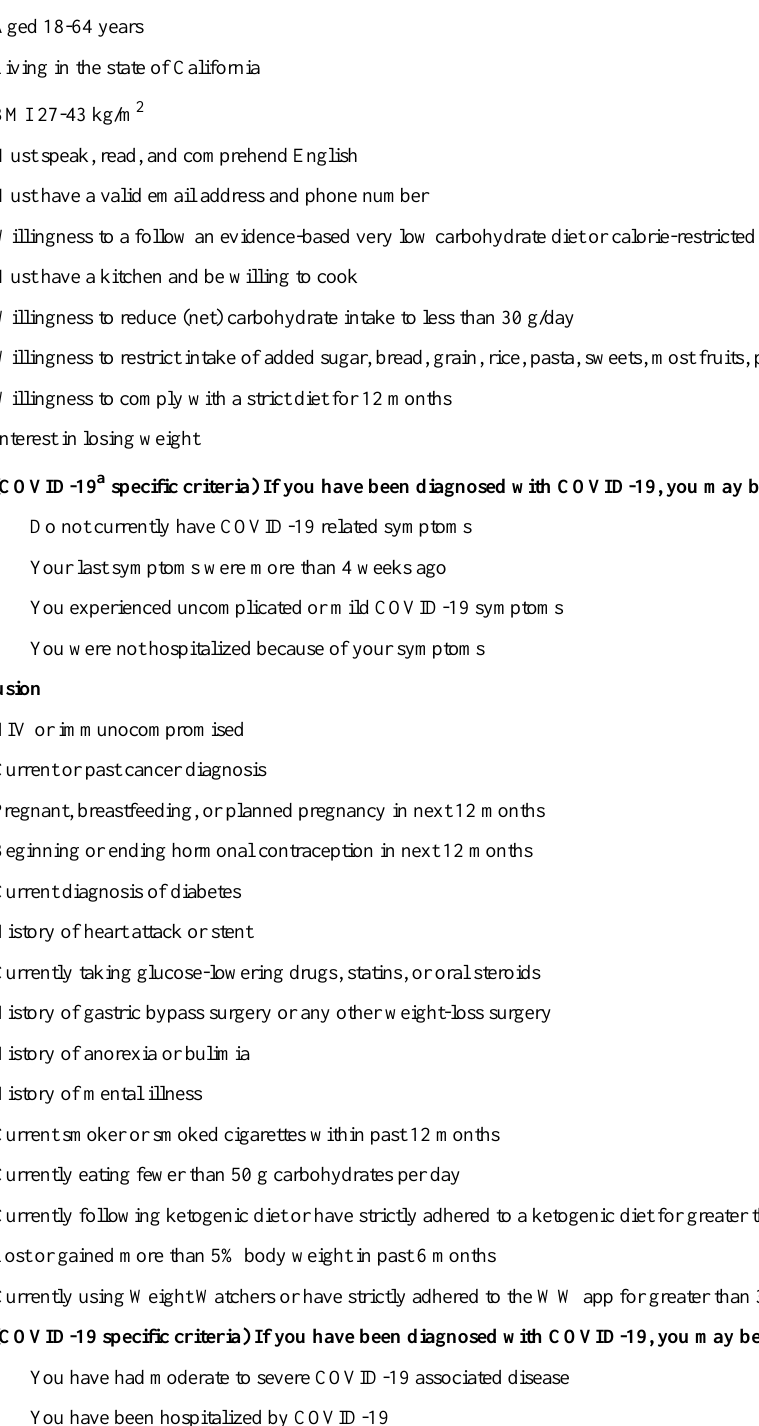
Table 2. Trial inclusion and exclusion criteria.